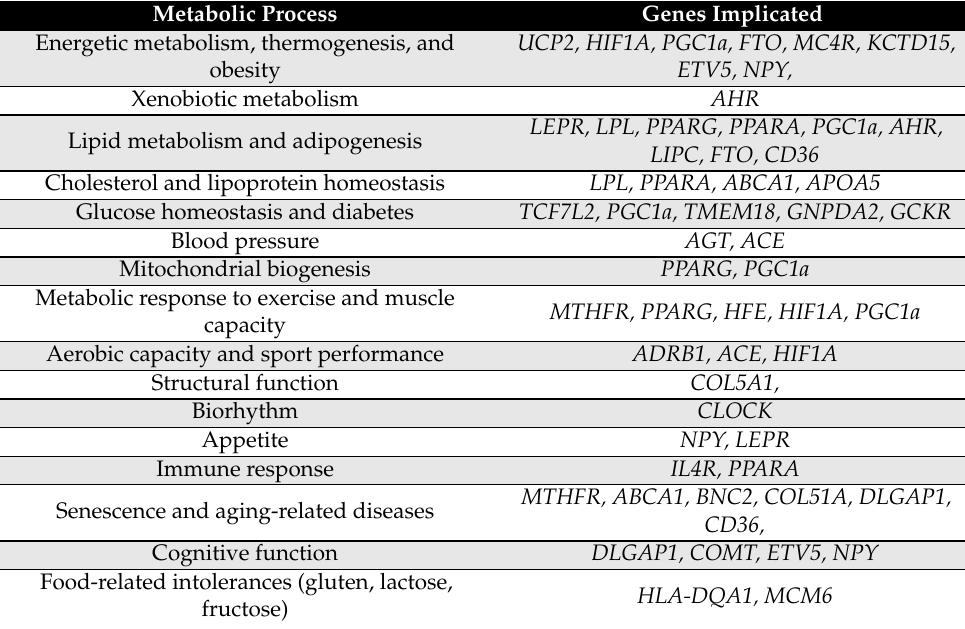
Table 2. List of the genes included in the customed TaqMan gene expression customized array cards (TLDAs) cards analysis, grouped in metabolic signaling pathways related to cell bioenergetics, glucose metabolism, lipid metabolism, inflammation, and metabolic stress, among others. Metabolic Process Genes Implicated UCP2, HIF1A, PGC1a, FTO, MC4R, KCTD15, Energetic metabolism, thermogenesis, and ETV5, NPY, obesity Xenobiotic metabolism AHR LEPR, LPL, PPARG, PPARA, PGC1a, AHR, Lipid metabolism and adipogenesis LIPC, FTO, CD36 Cholesterol and lipoprotein homeostasis LPL, PPARA, ABCA1, APOA5 Glucose homeostasis and diabetes TCF7L2, PGC1a, TMEM18, GNPDA2, GCKR Blood pressure AGT, ACE Mitochondrial biogenesis PPARG, PGC1a Metabolic response to exercise and muscle MTHFR, PPARG, HFE, HIF1A, PGC1a capacity Aerobic capacity and sport performance ADRB1, ACE, HIF1A Structural function COL5A1, Biorhythm CLOCK Appetite NPY, LEPR Immune response IL4R, PPARA MTHFR, ABCA1, BNC2, COL51A, DLGAP1, Senescence and aging-related diseases CD36, Cognitive function DLGAP1, COMT, ETV5, NPY Food-related intolerances (gluten, lactose, HLA-DQA1, fructose)